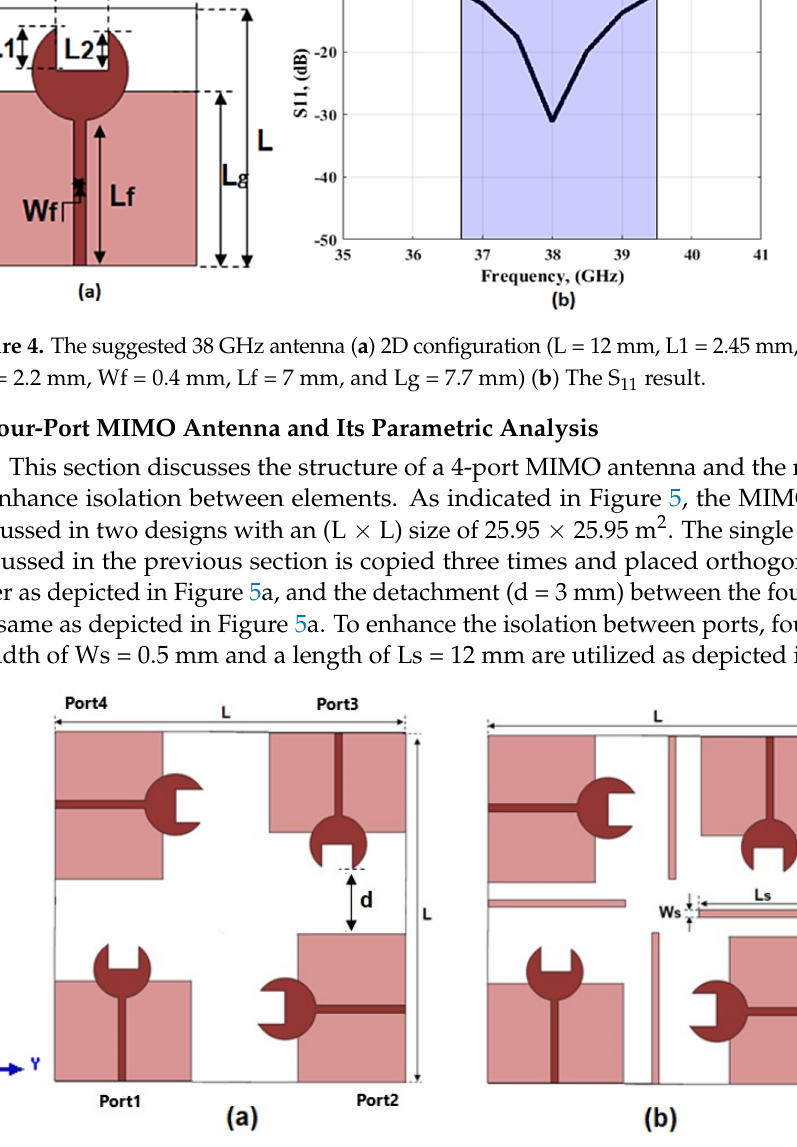
Figure 3. The W1 effect on the antenna performance.